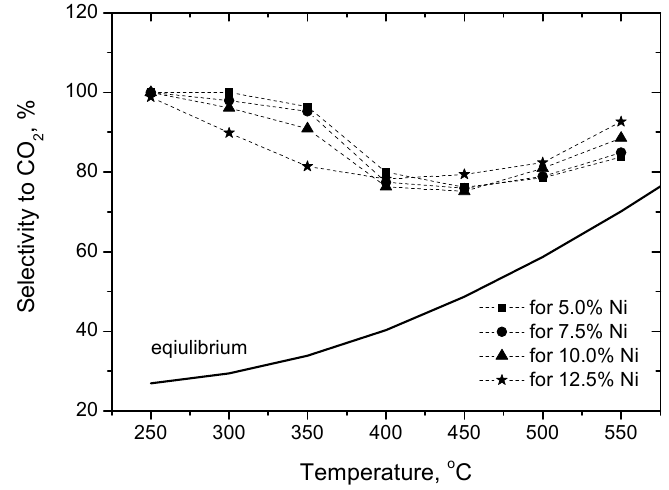
Figure 9. Temperature dependence of CO 2 selectivity at GHSV = 17,640 h − 1 over catalysts with different nickel loading.